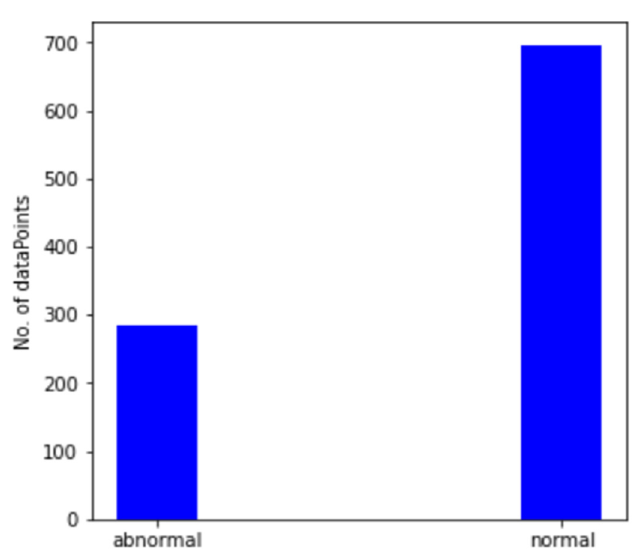
Figure 12. Count of normal vs. abnormal vibrational